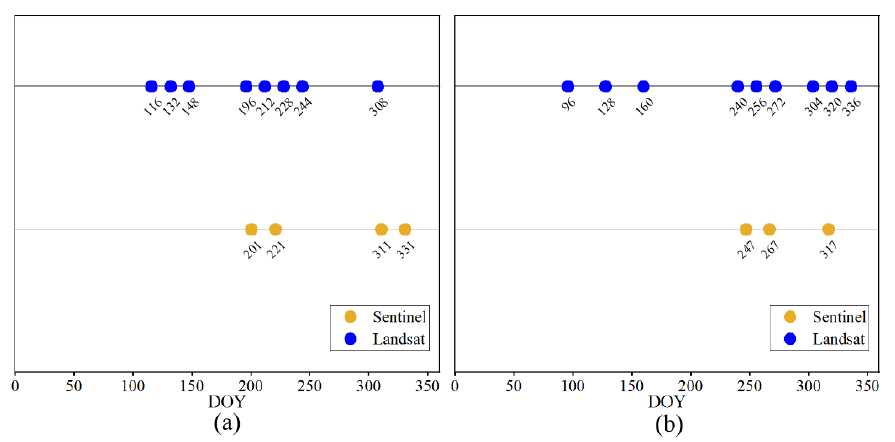
Figure 4. DOY of HLS images used in ( a ) BAH area and ( b ) NEA area.